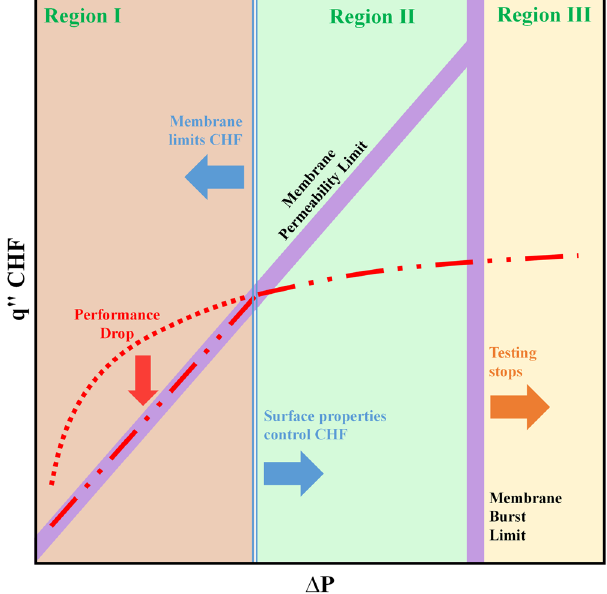
Figure 4. A schematic graph showing the main factors limiting the CHF depending on pool pressure (membrane is the limiting factor at Regions I and